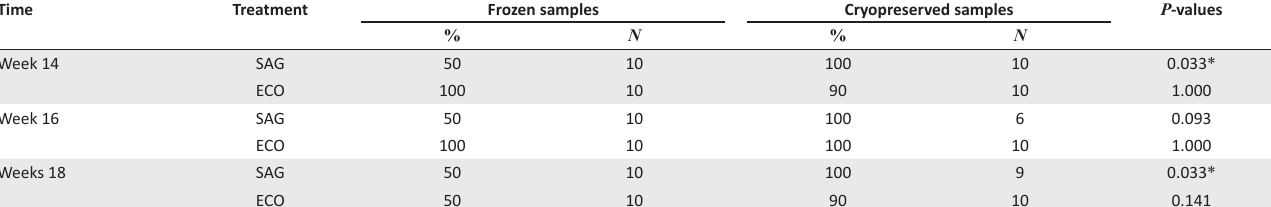
TABLE 1: Comparison between the survival of Streptococcus agalactiae (SAG) and Escherichia coli (ECO) for frozen and cryopreserved samples, for weeks 14–18. Time